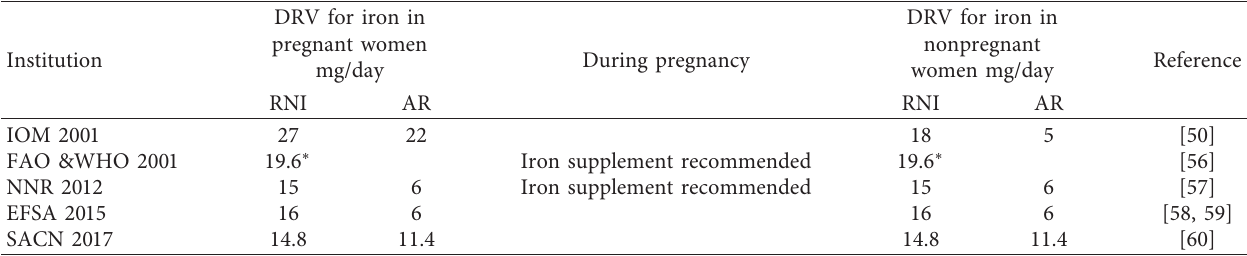
Table 3: Dietary Reference Values for iron. Reference Nutrient Intake and Average Requirement for dietary iron in pregnant women compared with nonpregnant women of reproductive